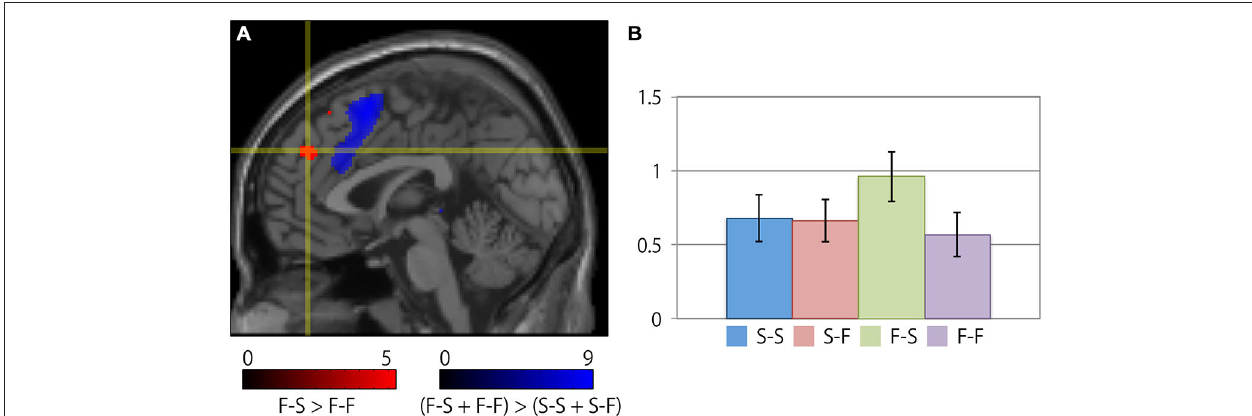
FIGURE 3 | Specific cortical activation during successful reconcentration for the next trial after recognition of negative feedback. (A) The crosshair icon marks the location of the activation peak on a sagittal slice ( x = 0 mm) on the MNI single subject template. The red and blue clusters represent the activation clusters obtained by the subtraction of the (F-S > F-F) conditions (red) and the [(F-S + F-F) > (S-S + S-F)] conditions (blue). The red and blue color scale indicates the t -values for the corresponding clusters. (B) Bar chart illustrating the percent signal changes within an activation cluster for each condition calculated using the MarsBar toolbox. The error bars represent the standard error of the